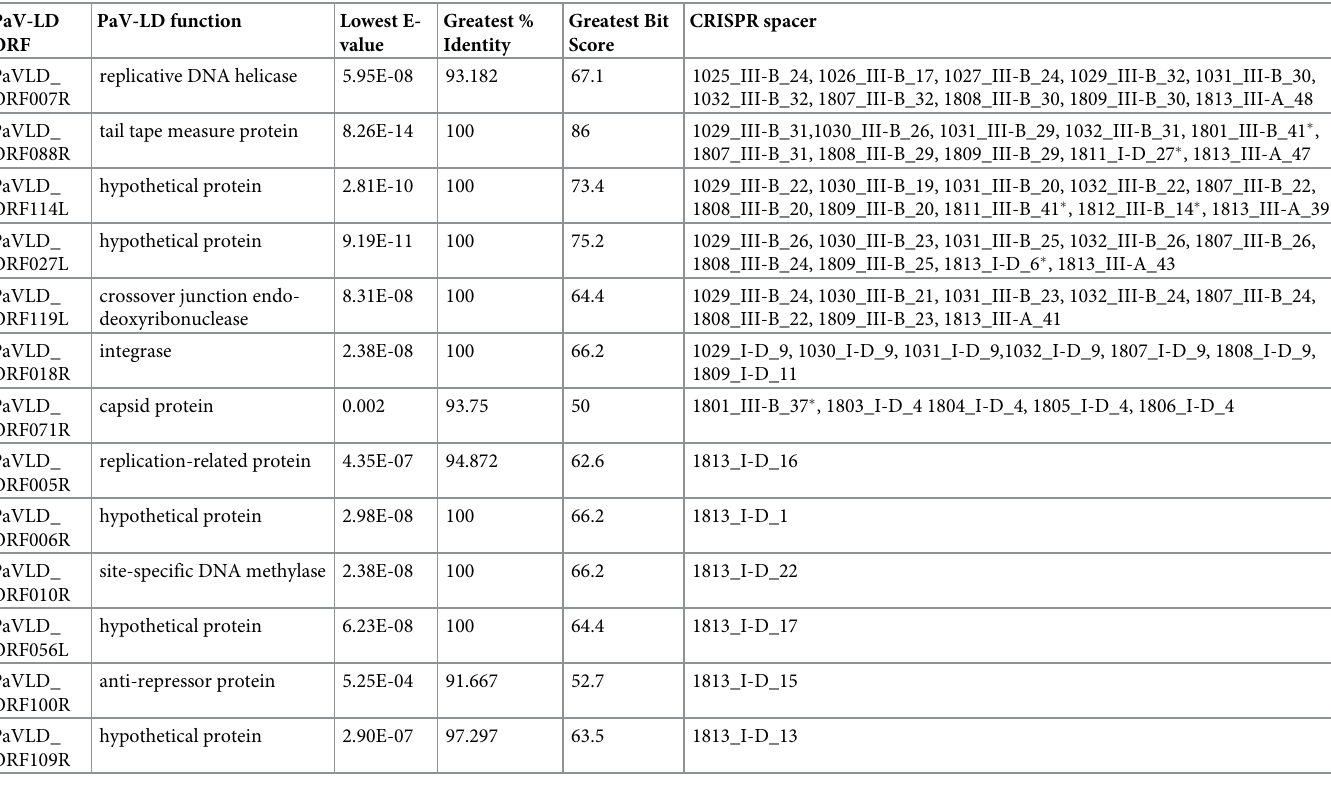
Table 3. Table of CRISPR spacer sequences with matching PaV-LD ORF and